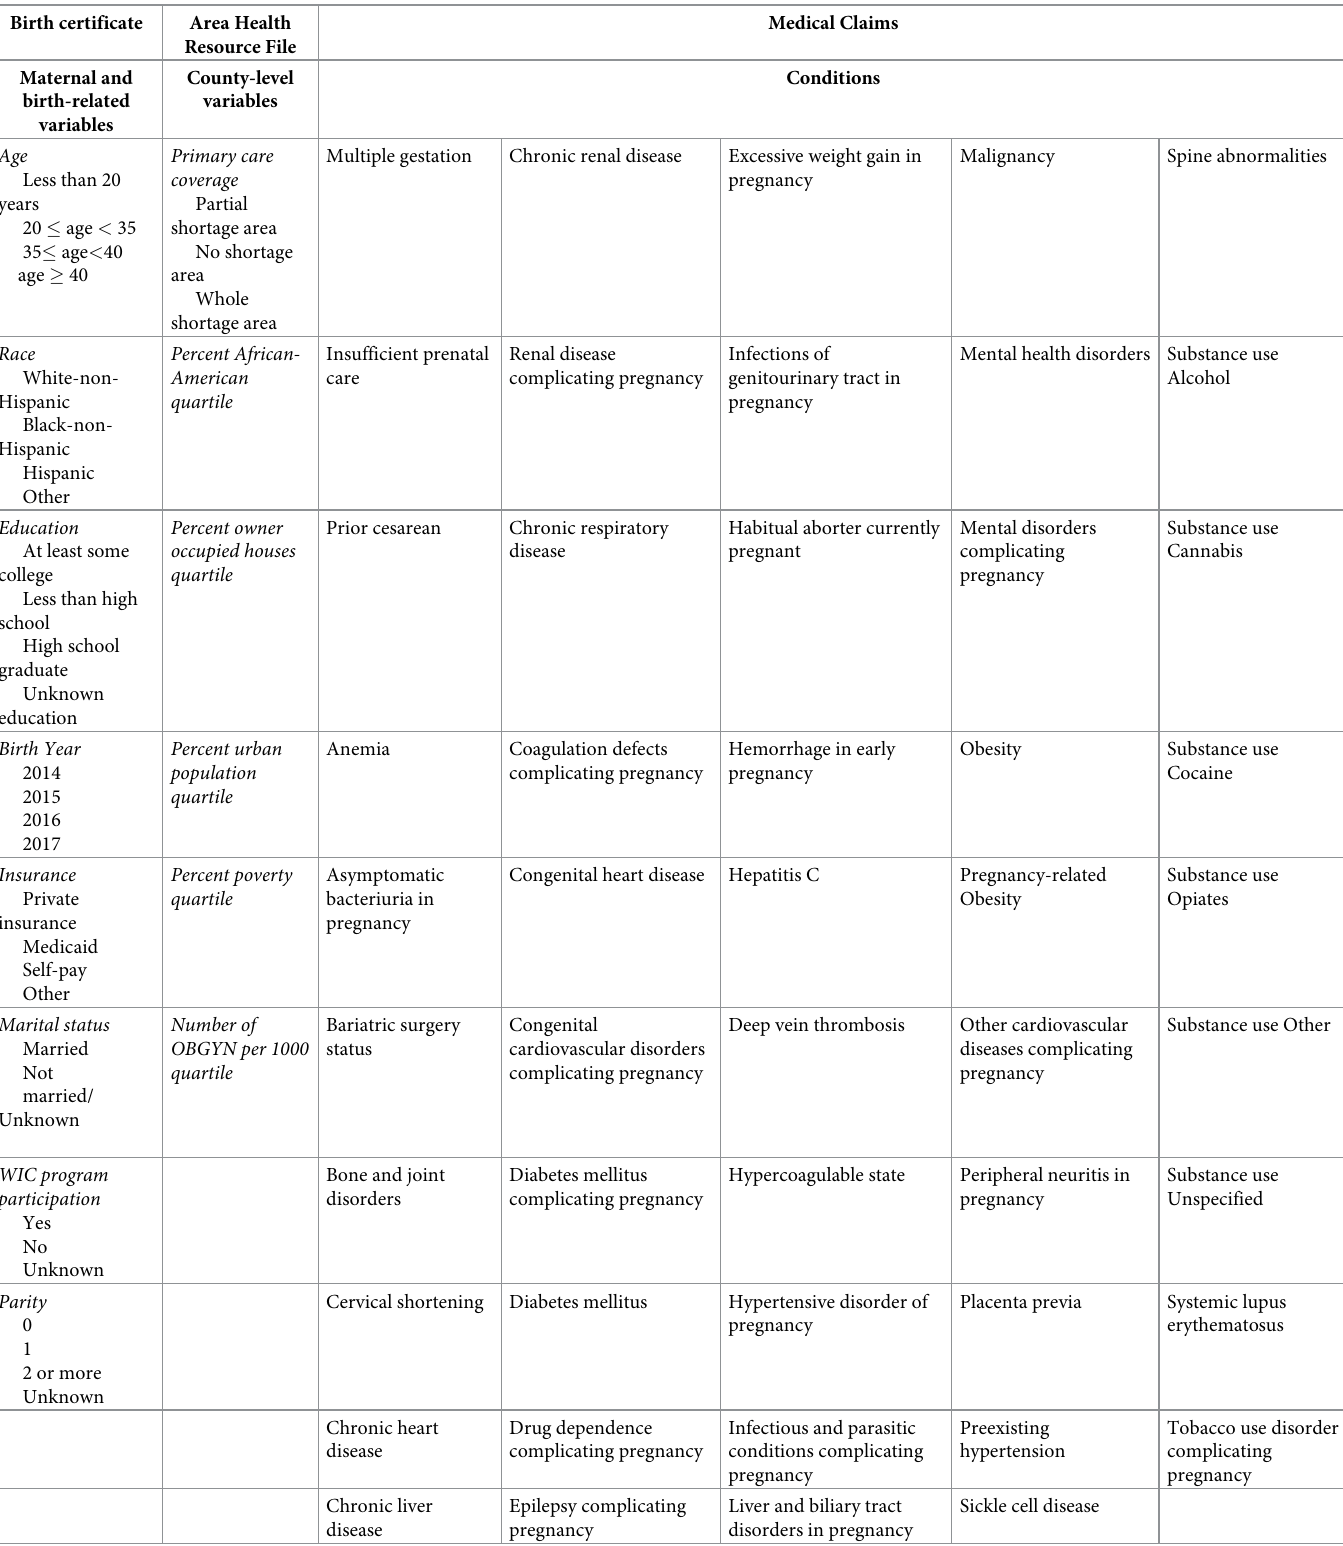
Table 1. Variables and data resources in the